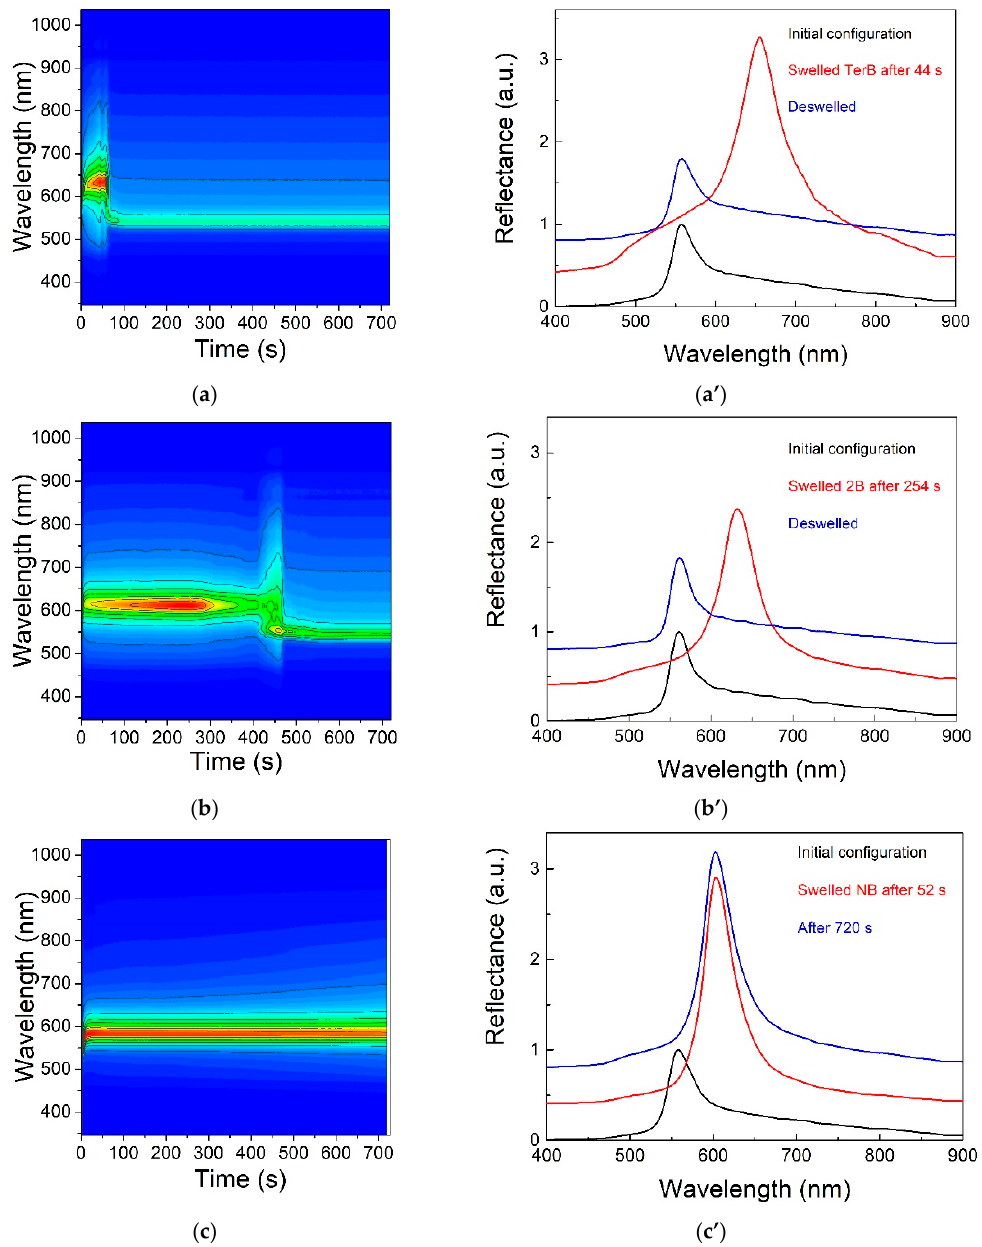
Figure 9. On the left, dynamic reflectance contour-plots spectra of: ( a ) 2-methylpropan-2-ol (TerB), ( b ) butan-2-ol (2B) and ( c ) butan-1-ol (NB), and, on the right, corresponding time-resolved optical responses ( a’ – c’ ). The measurements clearly show the differences typical of each isomer and the reversibility of the process. Reproduced with permission from [27].